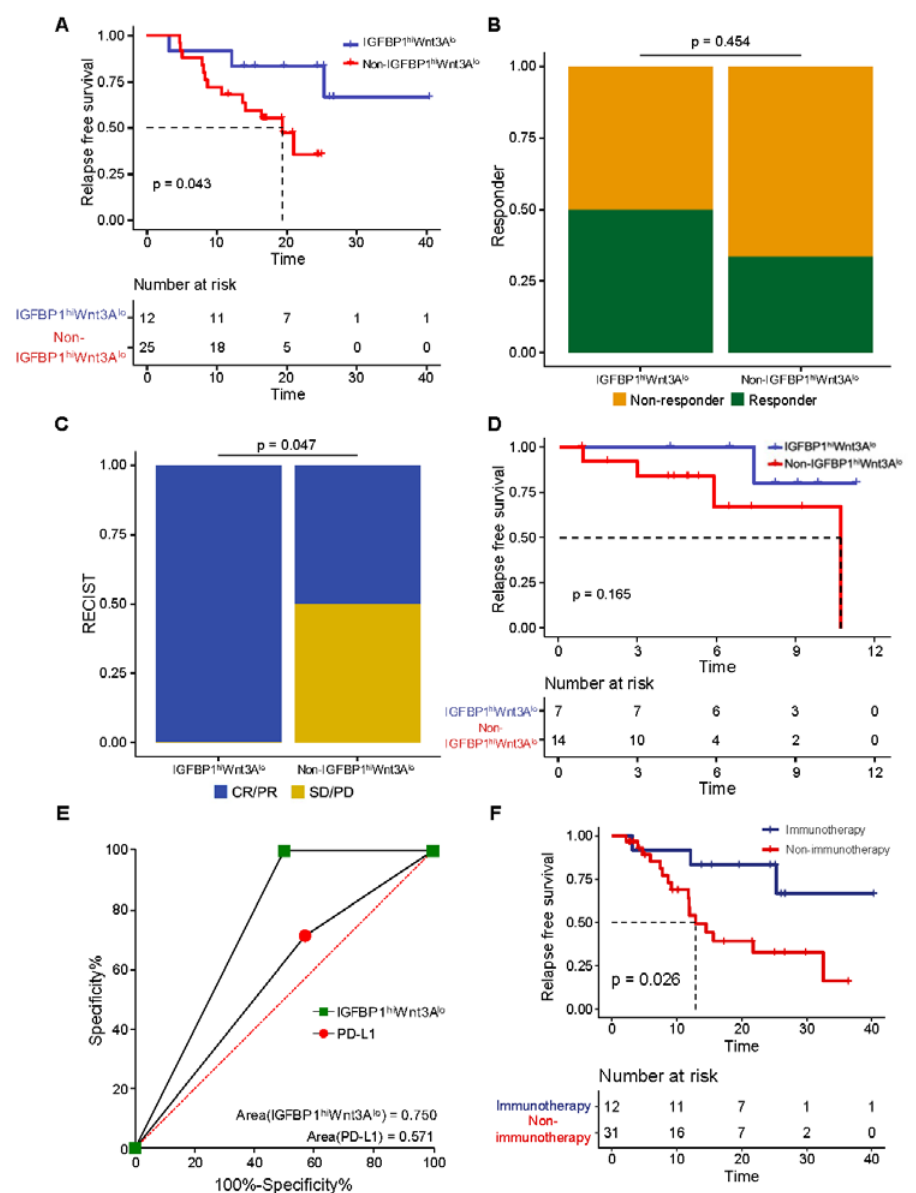
Figure 5. Relationship between the IGFBP1 hi WNT3A lo signature and immunotherapy of esophageal cancer. ( A ) Kaplan–Meier survival curve of RFS in the GSE183924 cohort; ( B ) bar chart showing the distribution of immunotherapy response among subtypes of the GSE165252 cohort; ( C ) bar chart showing the distribution of immunotherapy response among subtypes of the BJIM cohort; ( D ) Kaplan–Meier survival curve of RFS in the BJIM cohort; ( E ) ROC curve for assessing the predictive efficiency of the signature and PD-L1 expression; ( F ) comparison of RFS in IGFBP1 hi WNT3A lo subtype patients treated with or without immunotherapy.